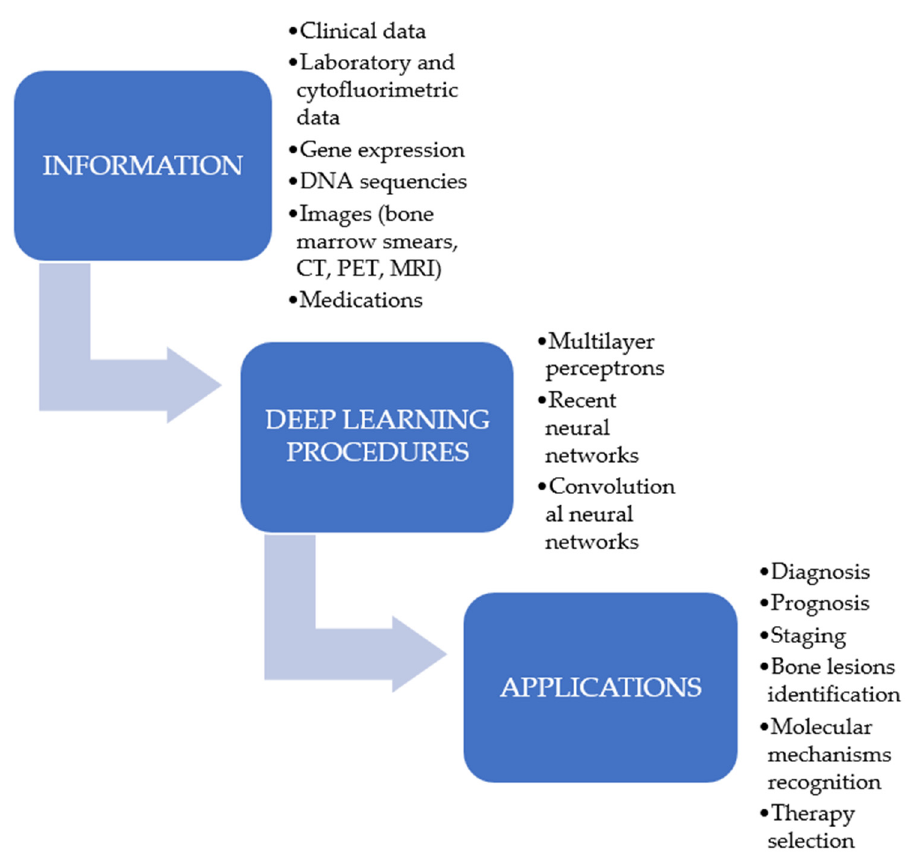
Figure 2. Possible applications of deep learning procedures in multiple myeloma research.